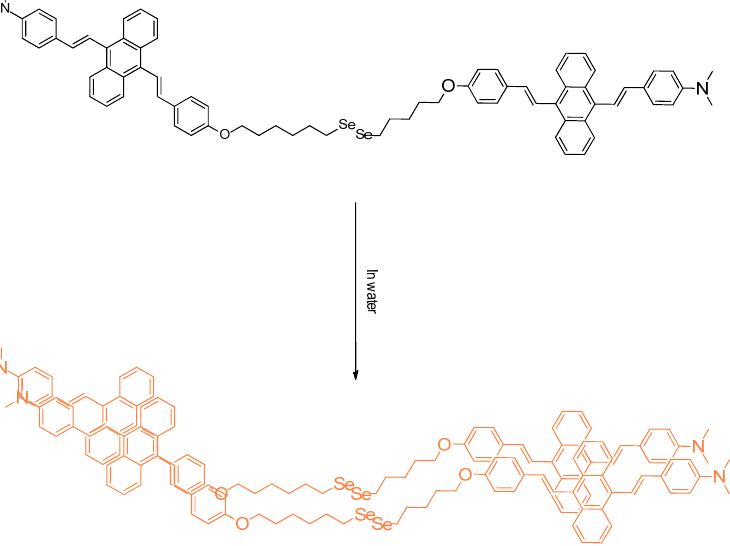
Figure 8. The diselenide system prepared by Tang et al. and its self–stacking form when introduced into water.